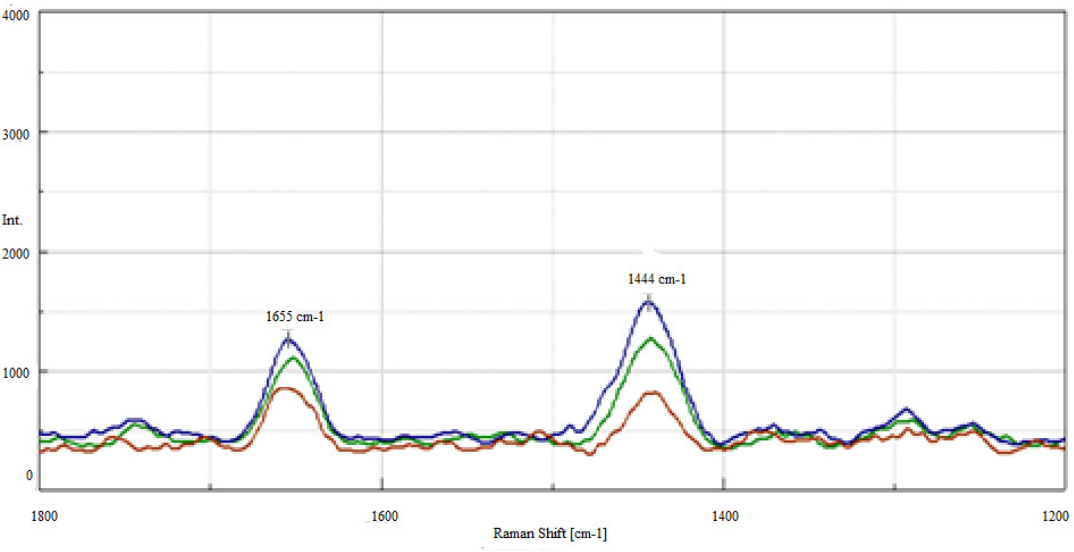
Figure 3. Raman spectra of A grease—green line, A_120 grease, oxidised at 120 °C—brown line and A_G oz grease after anti-wear test—blue line, in the 1800–1200 cm − 1 range.